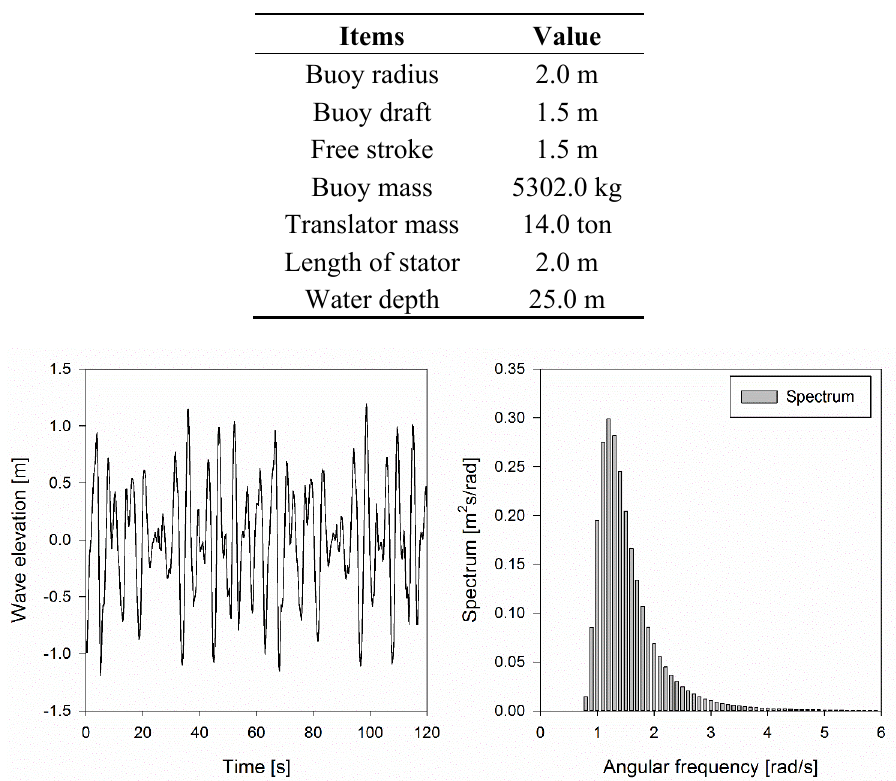
= 2 m, (cid:1846) = 5.24 (cid:3046) (cid:3043)